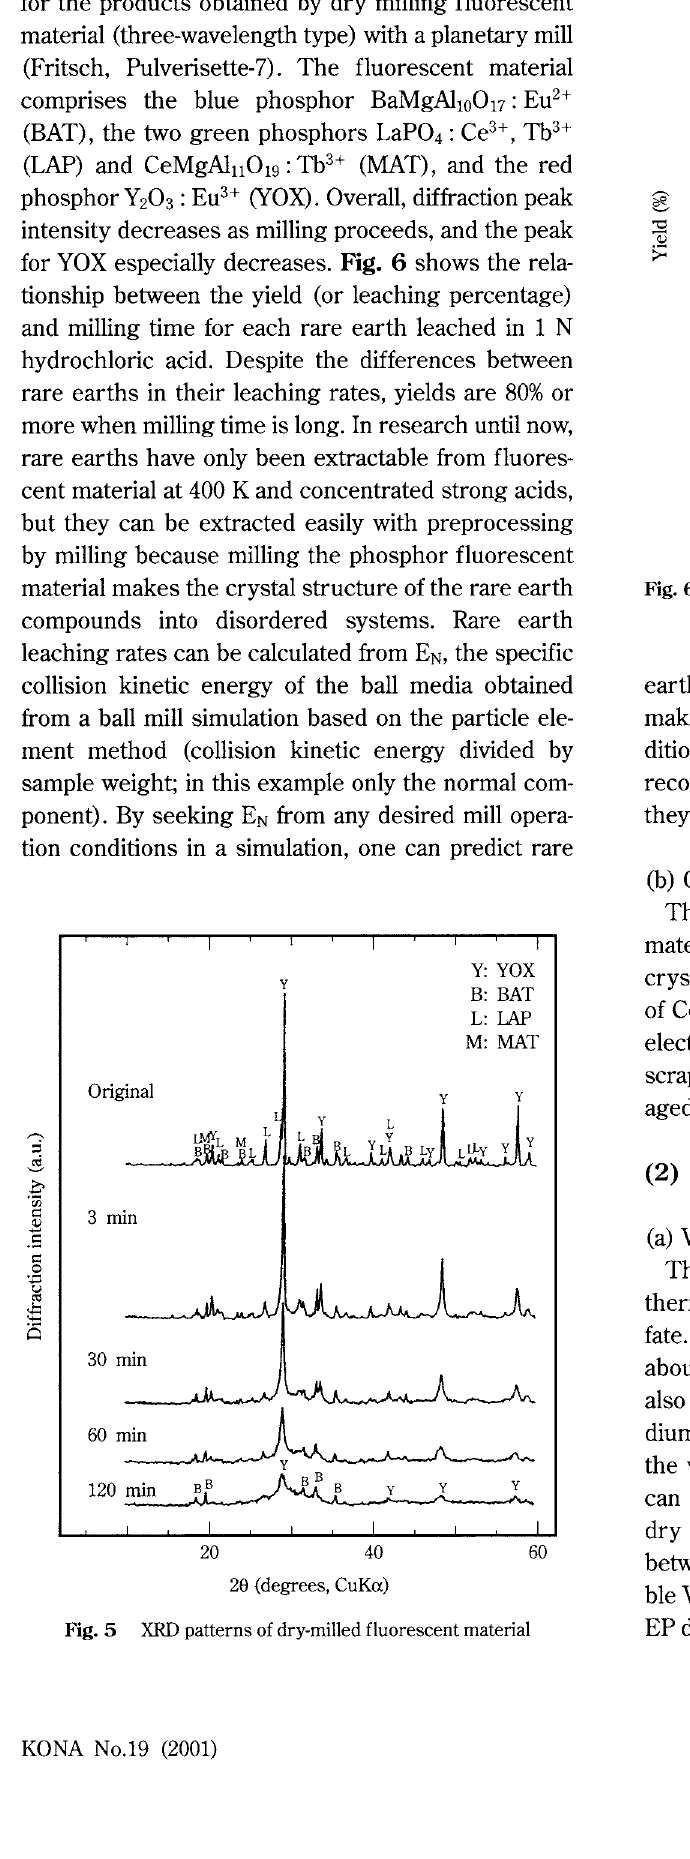
XRD patterns of dry·milled fluorescent material